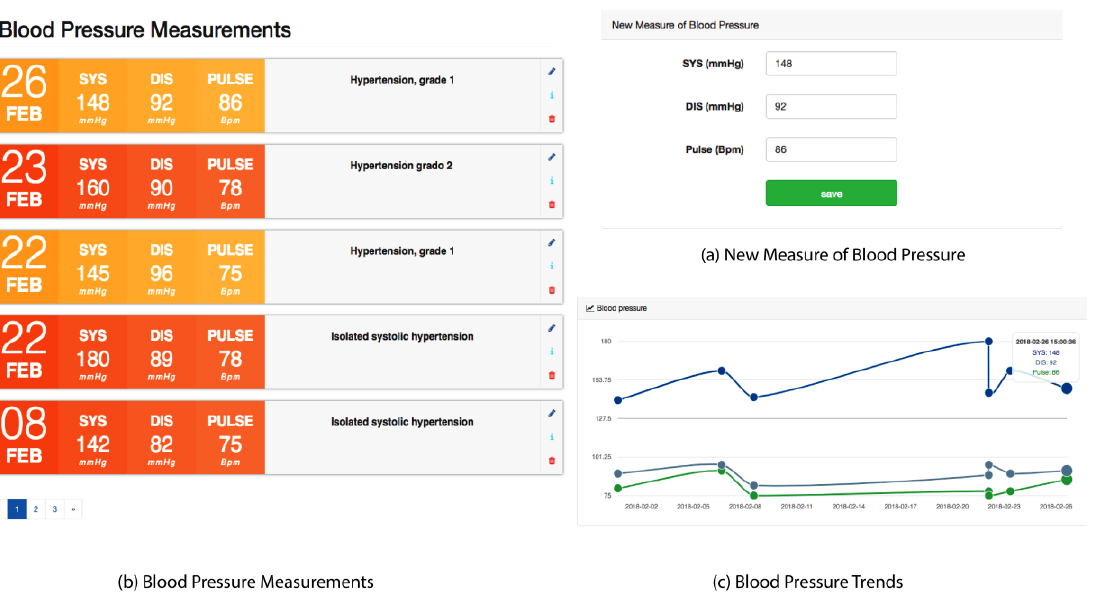
Figure 6. Blood pressure module.